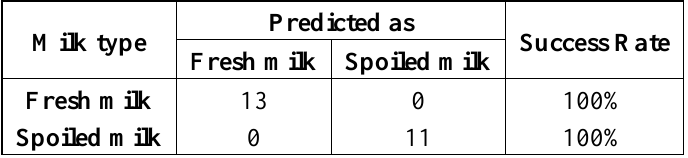
Table 7. MLP classification results of fresh and spoiled